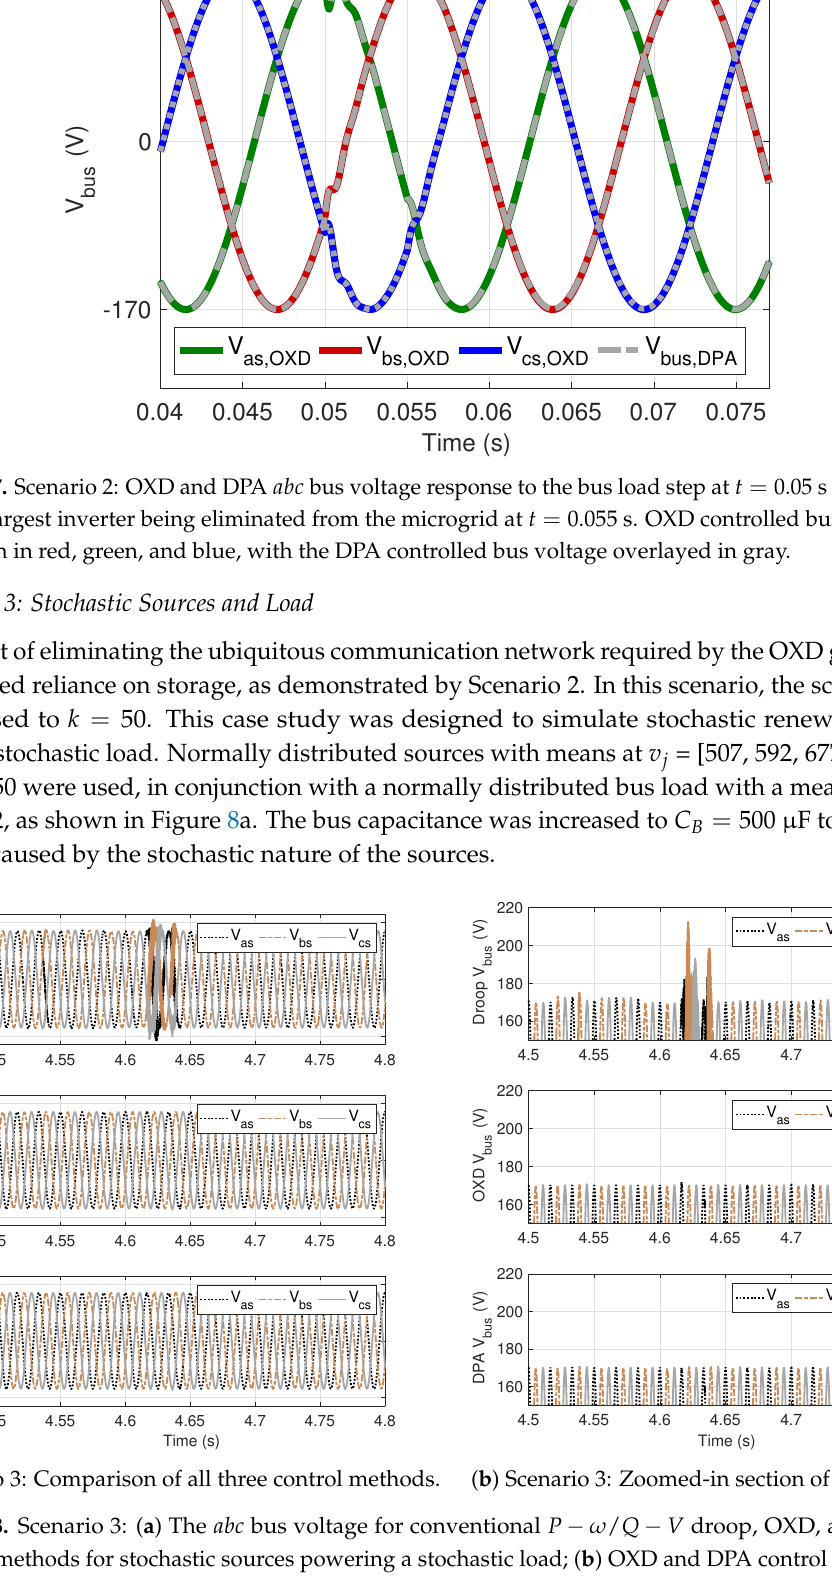
Figure 8. Scenario 3: ( a ) The abc bus voltage for conventional P control methods for stochastic sources powering a stochastic load; ( b ) OXD and DPA control methods outperform the conventional P